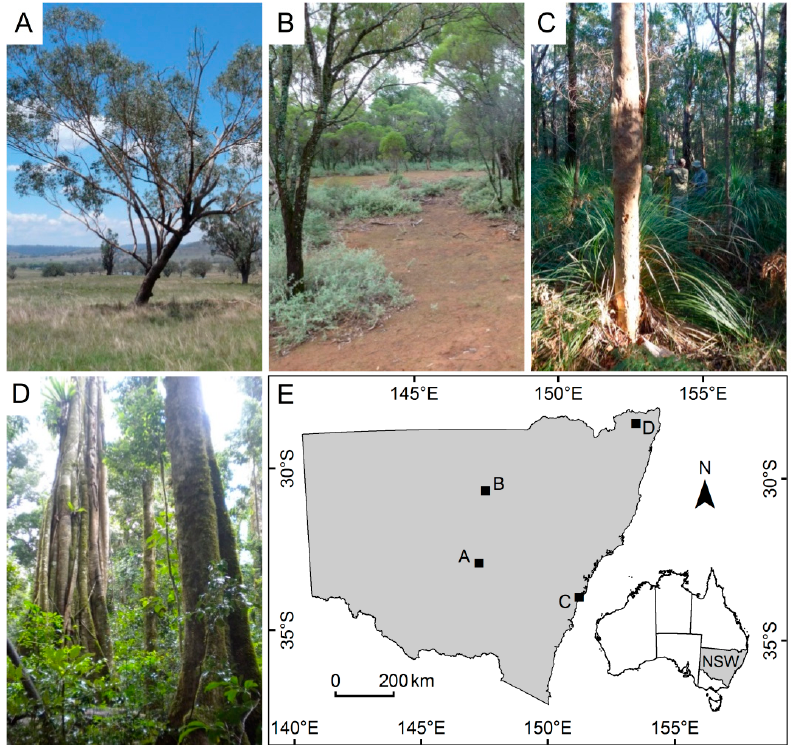
Figure 1. Examples of native trees present across New South Wales (NSW), Australia. ( A ) Remnant trees in the cleared agricultural land of the central west; ( B ) Open woodland in the semi-arid north west; ( C ) Sclerophyll forest on the east coast; ( D ) Rainforest in the north east; ( E ) The locations of each